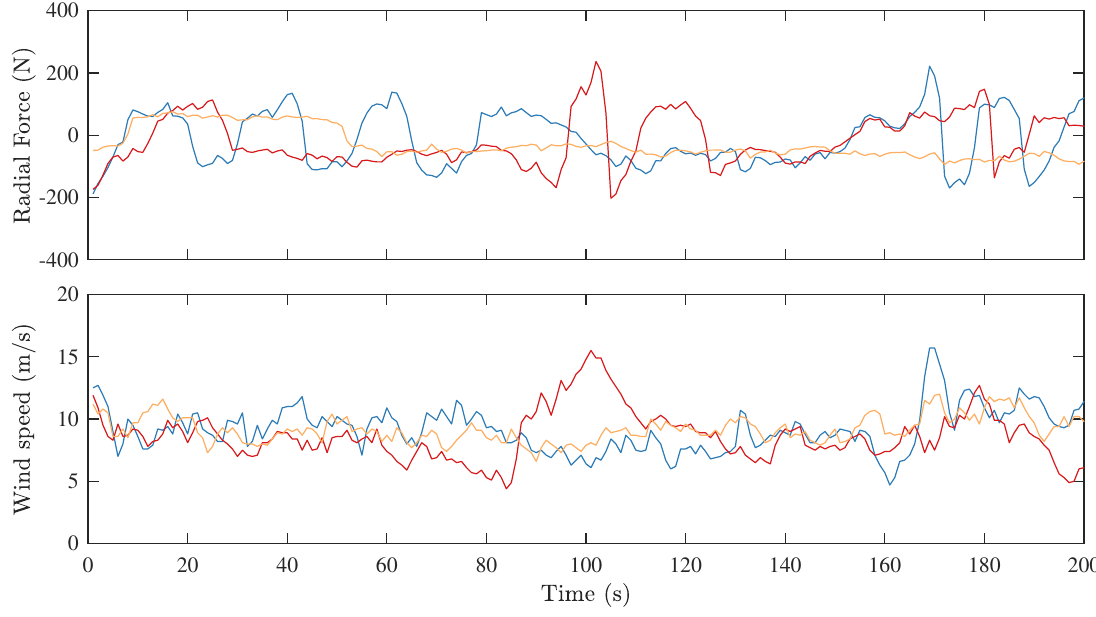
Figure 12. Measured forces with the turbine during electrical braking for similar absolute wind directions as in Figure 11. Note that the turbine is rotating slowly, so the angle of the wind relative to the blade is changing. Top : the radial force. Bottom : the corresponding wind